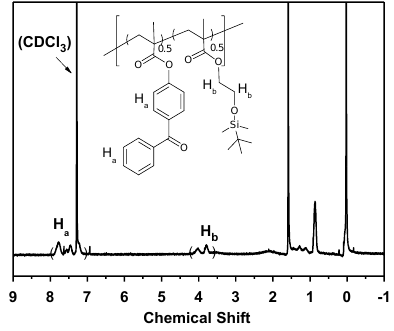
Figure 2. 1 H NMR spectrum of P(BPMA- co -ProHEMA) (400 Hz, CDCl 3 ). Table 1. Molecular characteristics of star-shaped block copolymers and resulting nanogels. Star-shaped Blcok